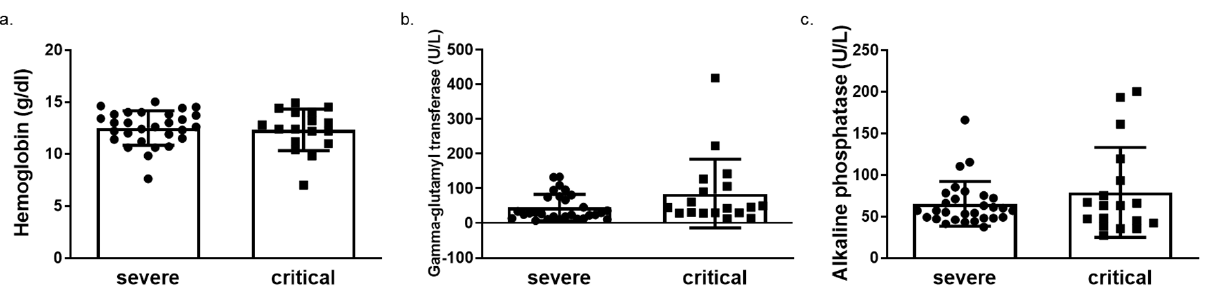
Figure 4. Unaltered levels of haemoglobin, gamma glutamyl transferase (GGT) and alkaline phos- phatase (ALP) levels in critical versus severe COVID-19 patients. Levels of ( a ) haemoglobin ( b ) gamma glutamyl transferase (GGT) and ( c ) alkaline phosphatase (ALP) in blood samples obtained on admission from COVID-19 patients by routine in-hospital blood analysis. Data are expressed as means ± SD. Statistical analysis was performed by Mann–Whitney U test. No statistically significant changes were observed.